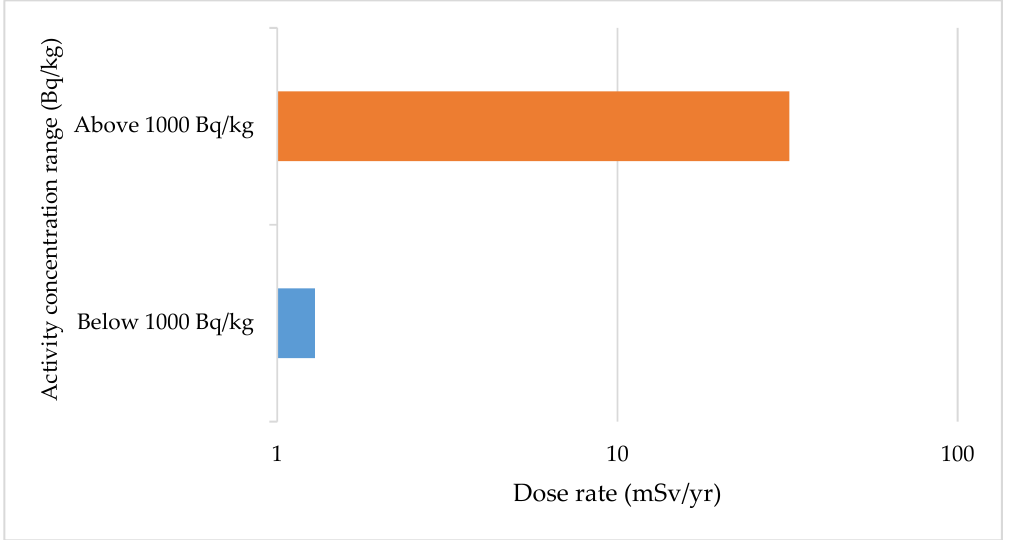
Figure 8. Dose from the NORM and LegacY Site Assessment code. A similar scenario used in RESRAD-ONSITE code was used in NORMALYSA to validate the dose obtained from RESRAD-ONSITE. External exposure and inhalation were the pathways considered. Radionuclide concentrations in the contaminated landfill and air of the contaminated site were used as input data for dose calculations. Table 6 summarizes all input parameters used in calculating the dose using NORMALYSA computer code.